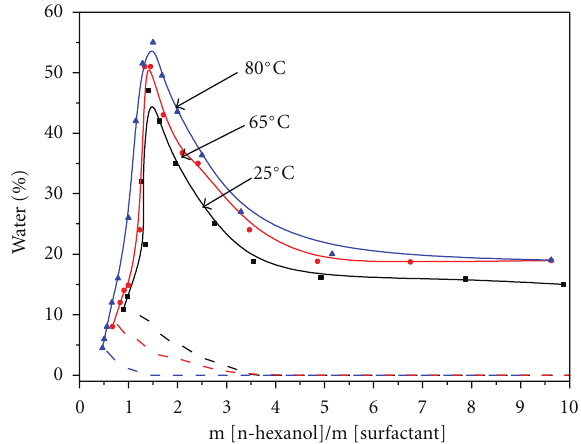
Figure 2: Relationship between water solubilization and mass ratio of n-hexanol to